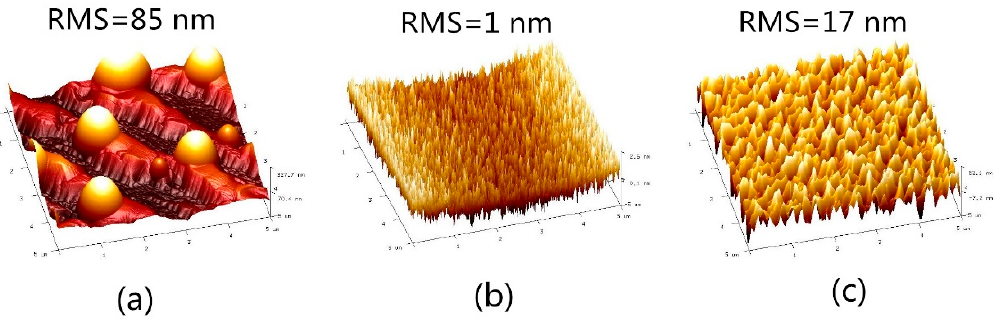
Figure 10. AFM of InPBi films grown at ( a ) 364 °C; ( b ) 324 °C and ( c ) 275 °C.